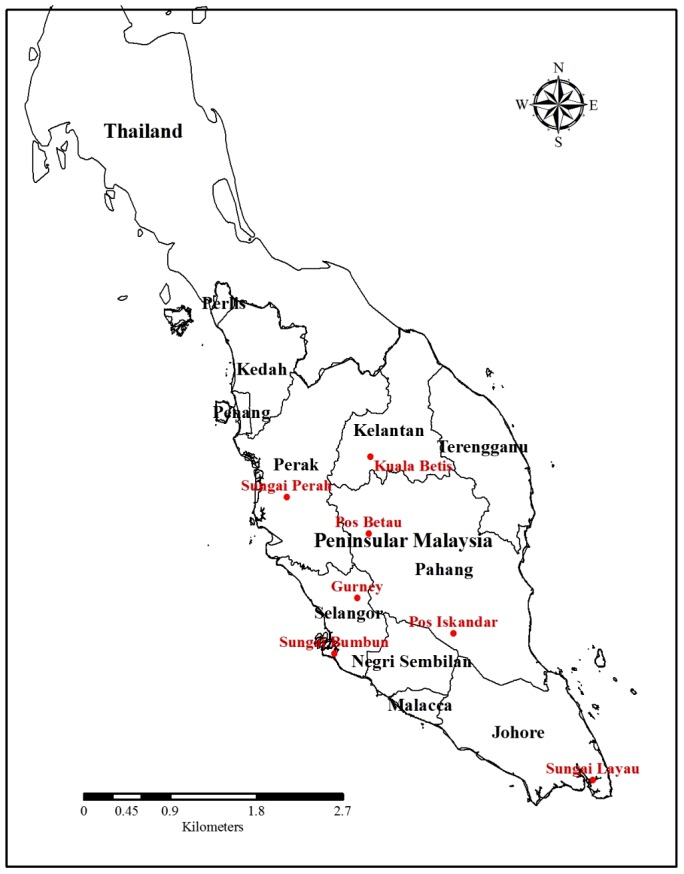
Location of the study areas in West Malaysia.